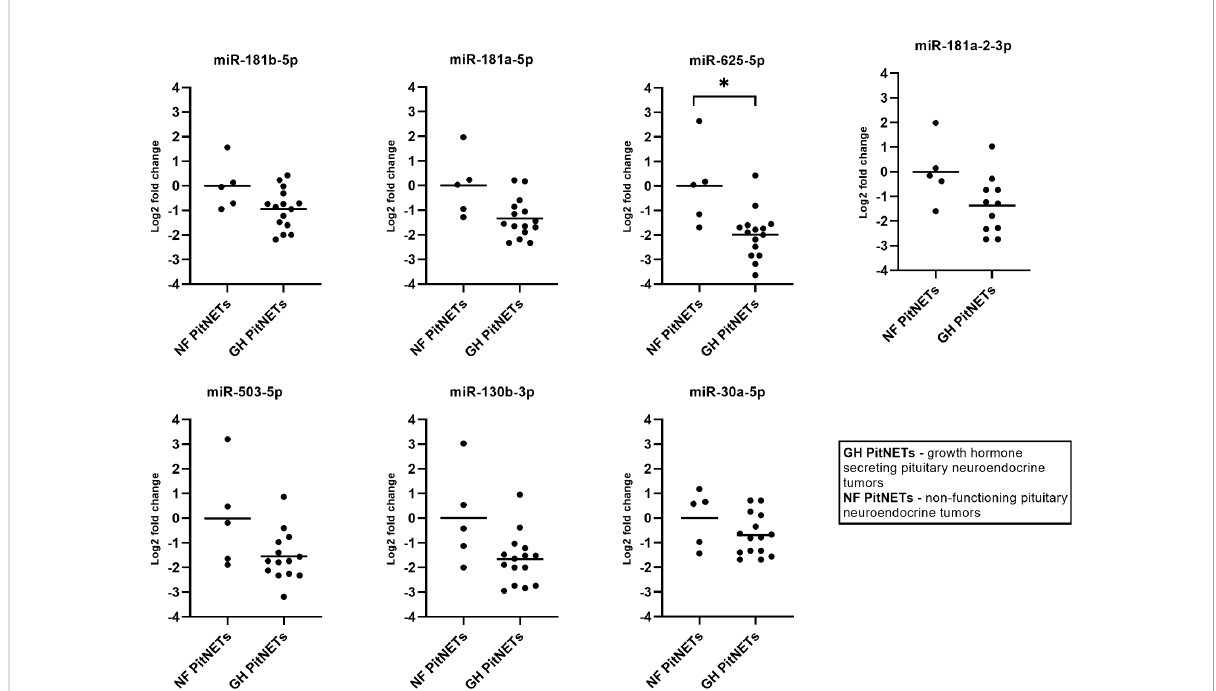
FIGURE 7 Expression by qPCR of seven candidate miRNAs in GH secreting PitNET patients ’ plasma (n = 15) vs NF FSH/LH PitNET patients ’ plasma (n = 5). With “ * ” are marked changes with P < 0.05. P values were calculated using multiple linear regression by including the following facots: age, sex, body mass index, tumor type, treatment (somatostatin analogue treatment, no